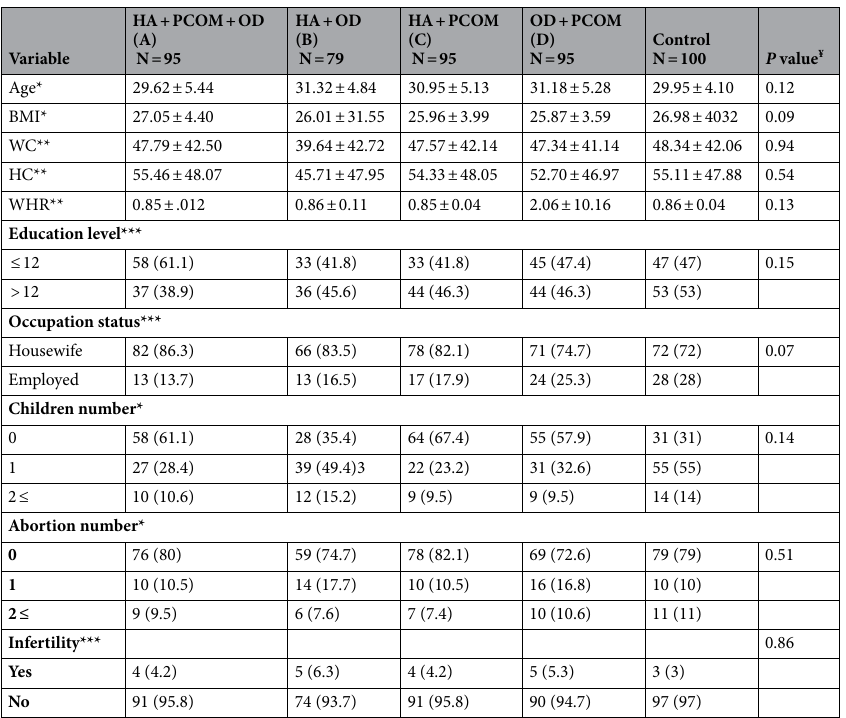
Table 2. Comparison of demographic and anthropometric characteristics between different PCOS phenotypes and control group. PCOS Polycystic Ovary Syndrome, PCOM Polycystic Ovaries Morphology, OD Ovulatory Dysfunction, HA Hyperandrogenism, WC Waist Circumference, BMI Body Mass Index, WHR Waist to Hip Ratio, HC Hip Circumference. *Values are given as Mean ± SD using the ANOVA test. ** Values are given as Mean ± SD using the Kruskal–Wallis test. ***Values are given as number/percent using the Chi-square test. ¥ Pairwise comparison with level